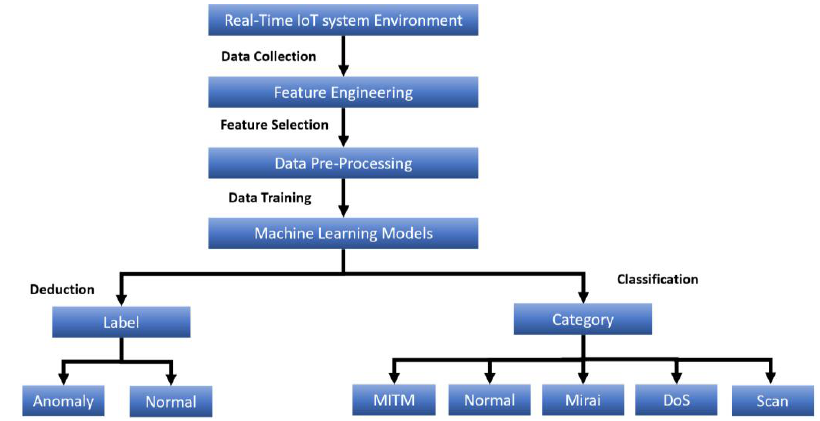
Figure 11. The architecture of ML models for prediction instruction attacks.